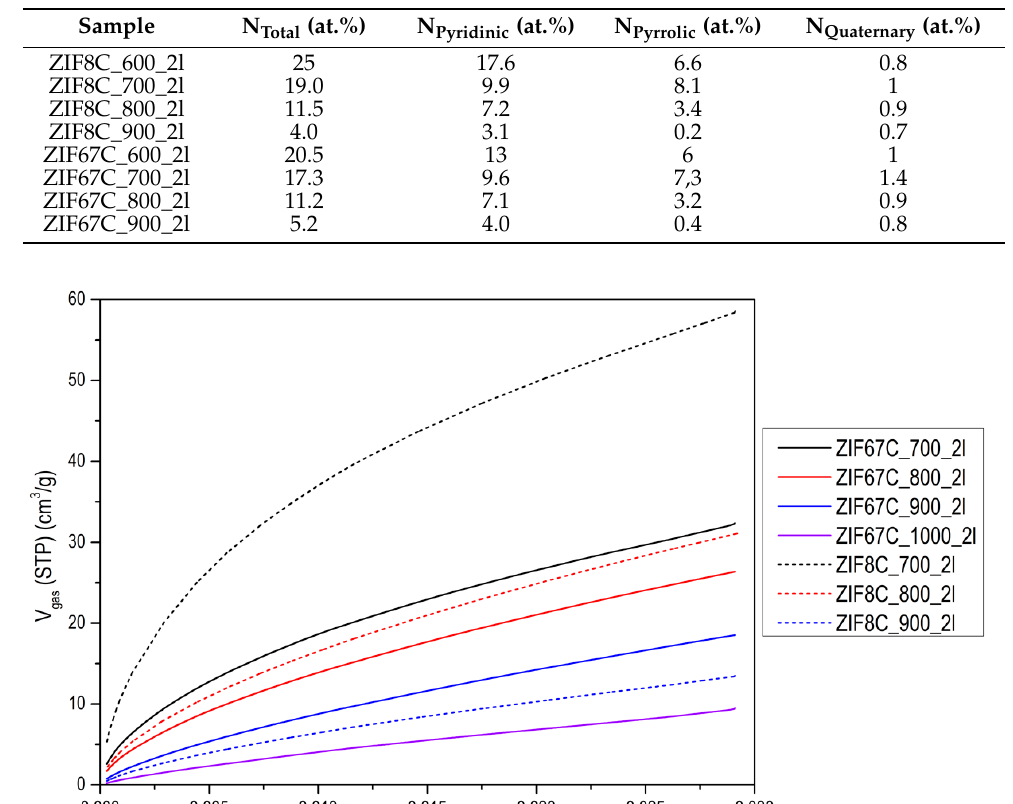
Table 2. Summary of the XPS results with classification of N into its expected bond types.